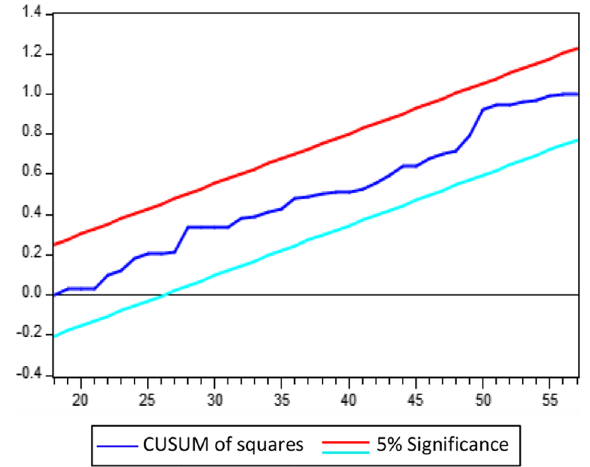
Fig. 10 Plot of Cumulative Sum of Squares of Recursive Residuals (CUSUMSQ)